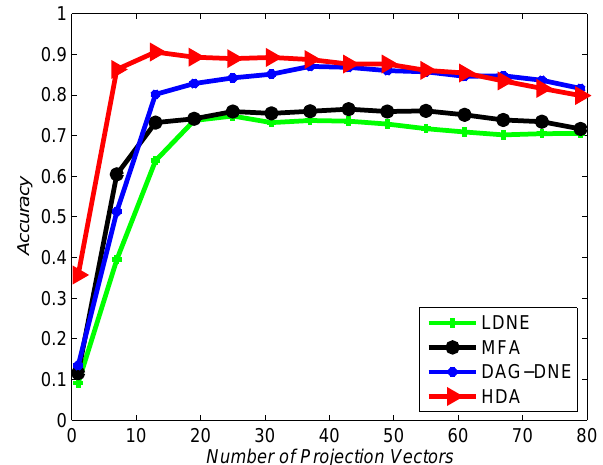
Figure 8. Accuracy vs. Number of Projection Vectors on the UMIST dataset under K = 3.